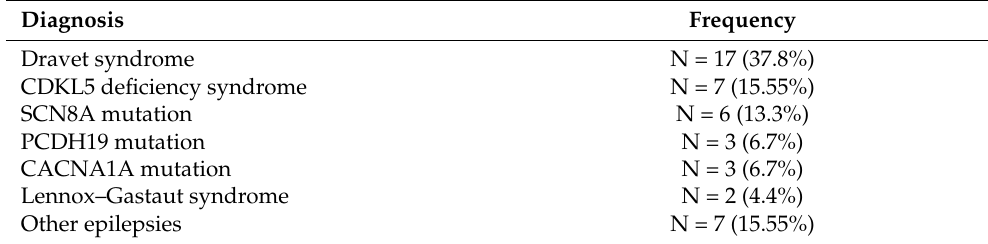
Table A1. Diagnostic of offspring